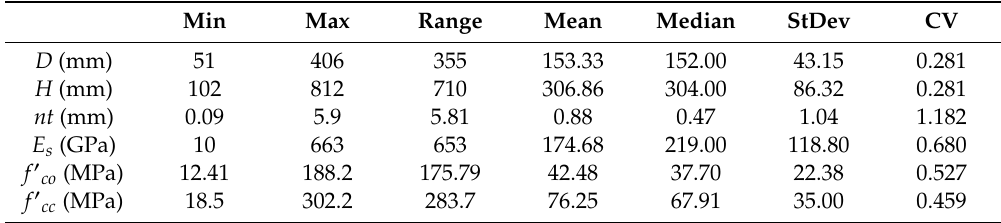
Table 2. Statistic properties of the parameters included in the constructed database of the strength model (708 samples).